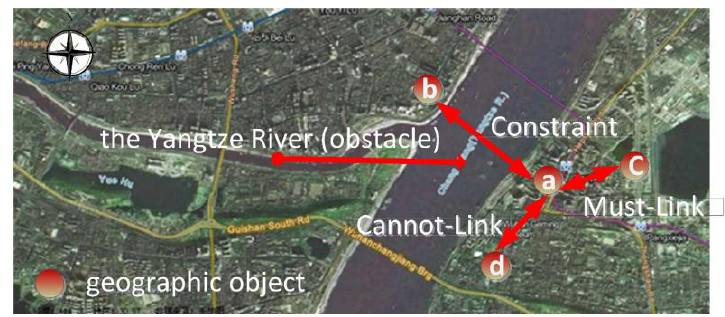
Figure 10. Constraint between point a and point b for obstacle, Must-Link constraint between point a and point c for belong to the same administrative district, Cannot-Link constraint between point a and point d for belong to the different administrative district . There is no figure reused directly from other publication.